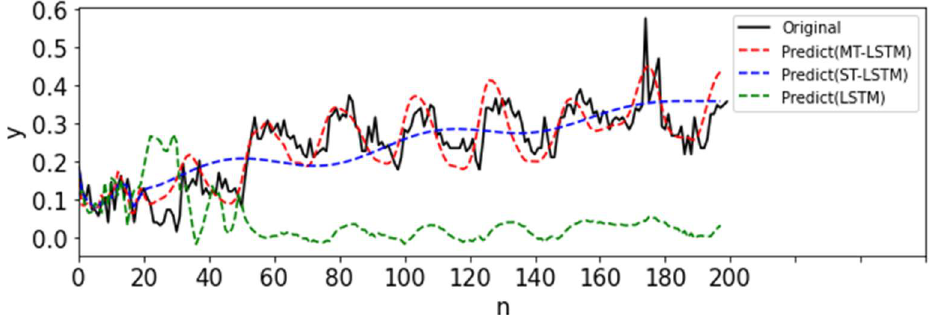
Figure 12. Imputation results of MTGP and STGP for the extreme situation (after normalization).